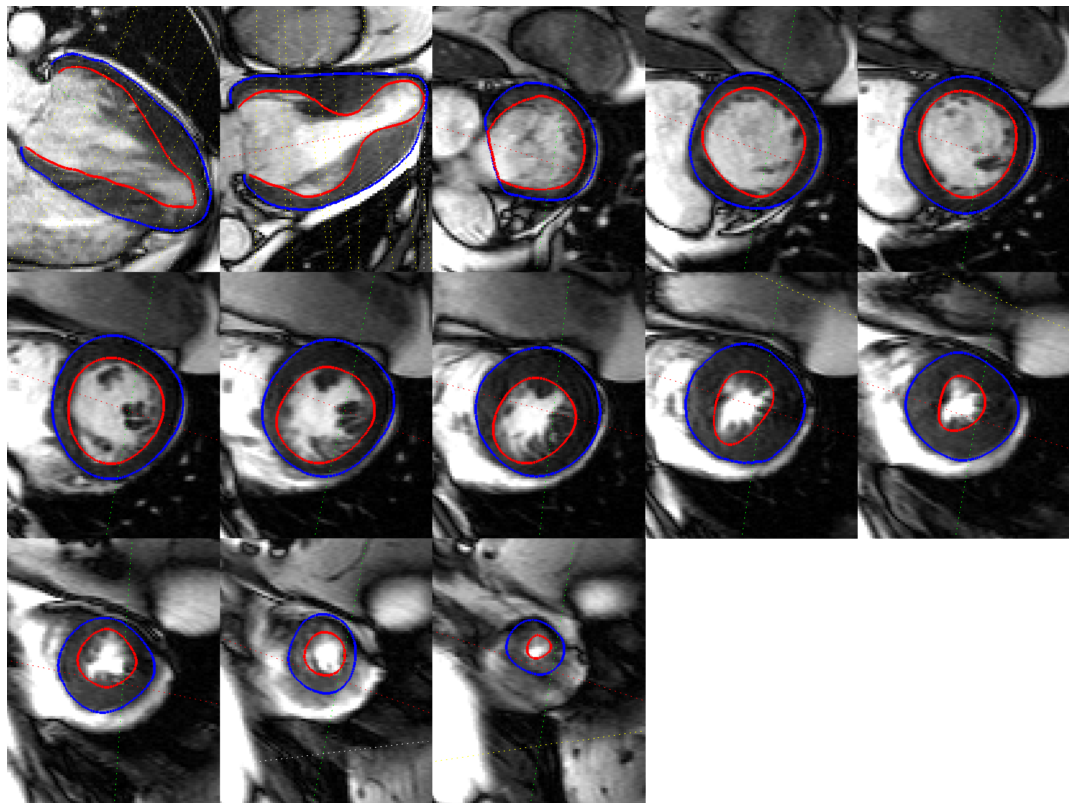
Figure 8. Different segmented CMR acquired contours on a severe abnormal anatomy.